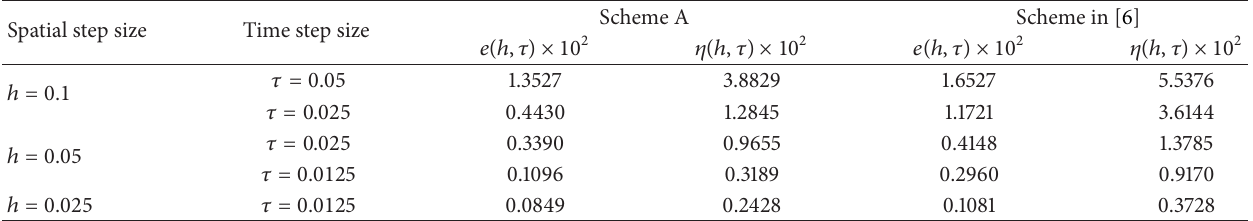
Table 3: Error comparison for Scheme A and scheme in [6] with 𝜃 = 0.5 at time 𝑇 = 5 .